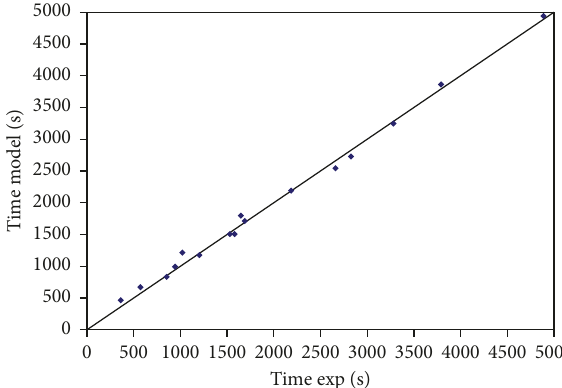
Figure 5: Experimentally determined drying time compared to the time calculated with equation (5).